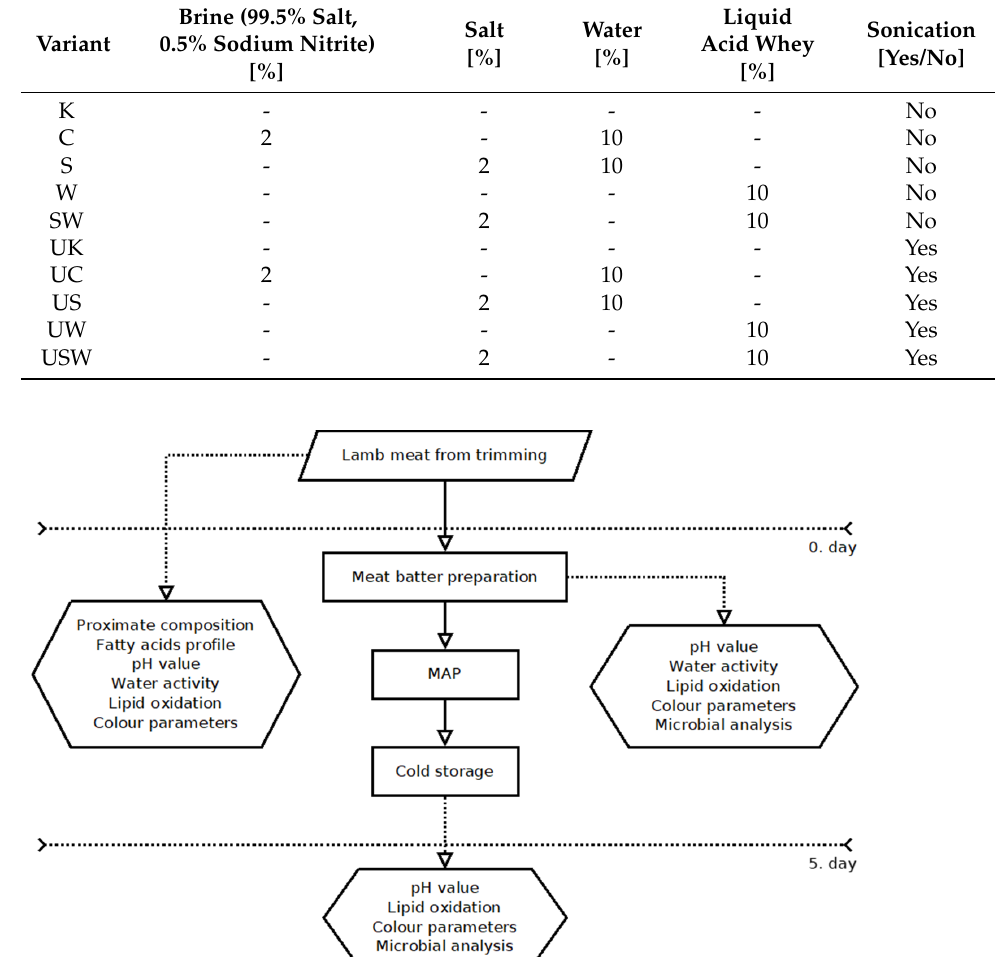
Table 1. Ingredients and processing of lamb stuffing.